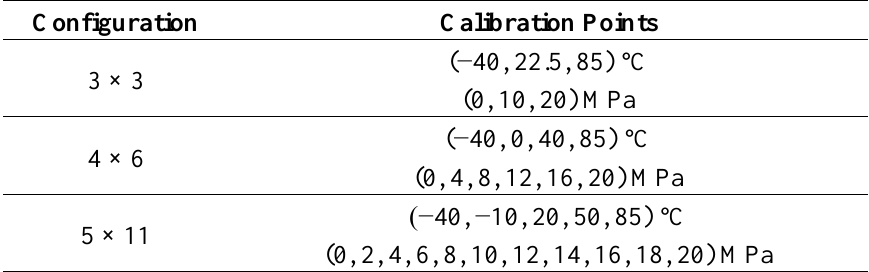
Table 1. The configurations of calibration